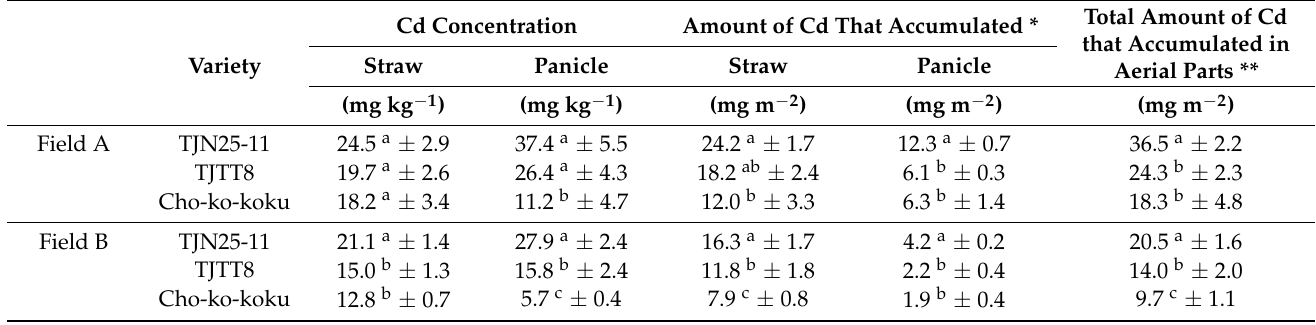
Table 4. Cd concentration and amount of Cd accumulated in rice grown under early drainage water management in two farmers’ fields.